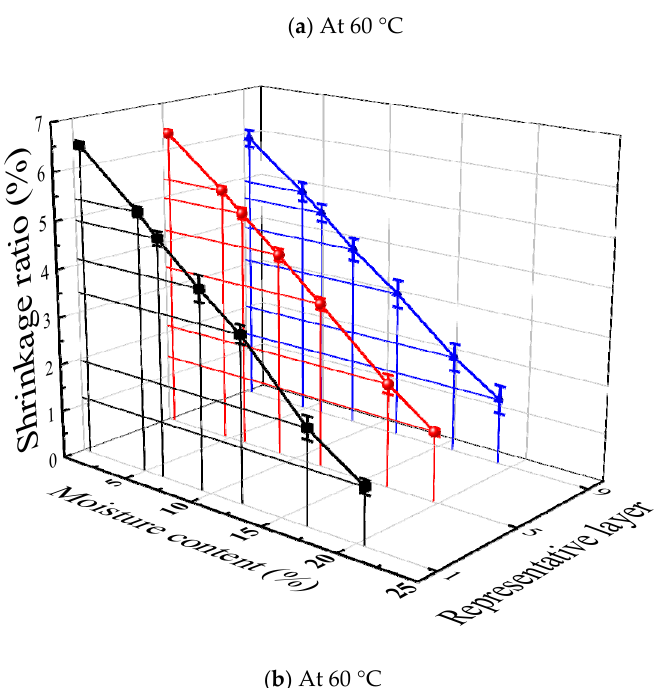
Figure 2. Cont. Figure 2.